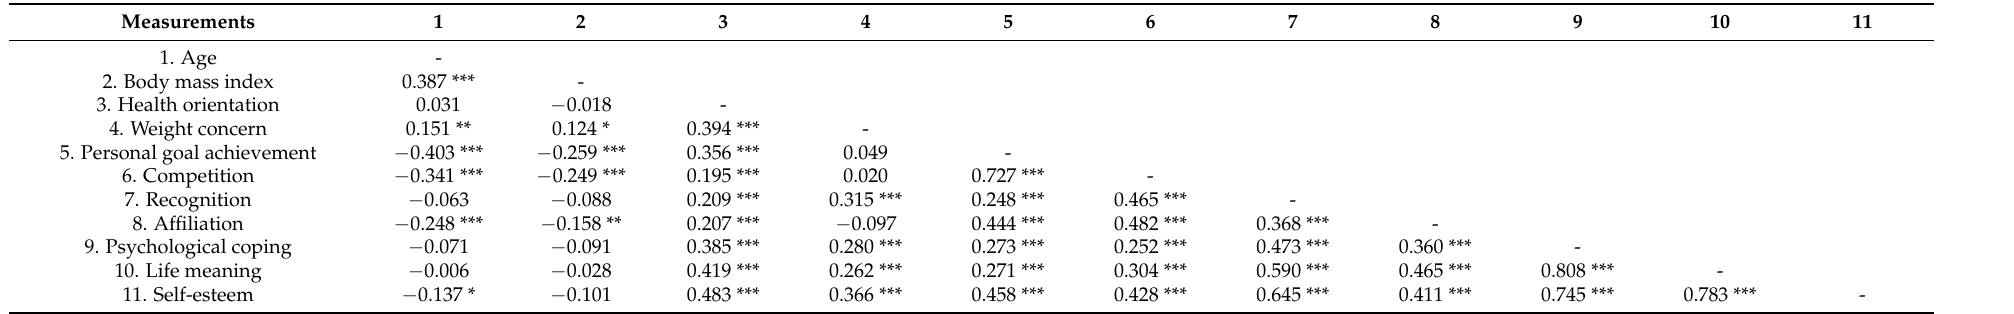
Table 2. Bivariate correlations among study